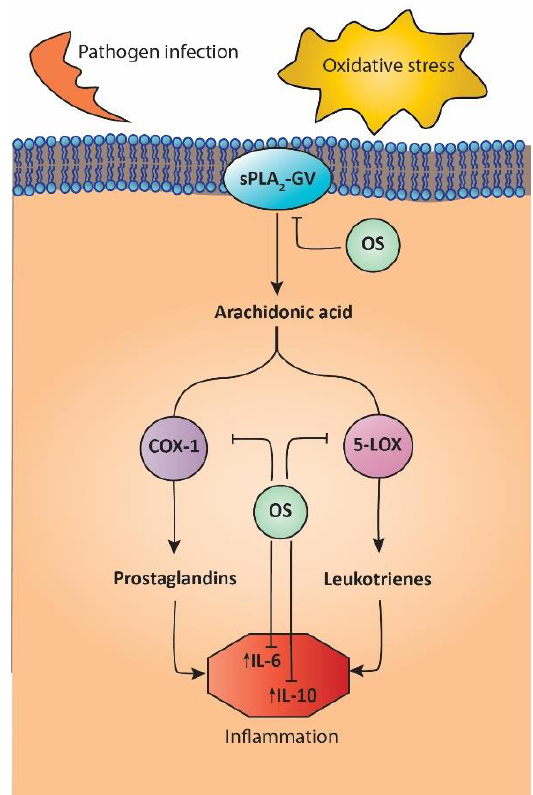
Figure 4. Origanum syriacum modulates the inflammatory response. Origanum syriacum blocks the hydrolysis of arachidonic acid from phospholipid membranes by the phospholipase A2 sPLA2-GV, which is normally released by inflammatory stimuli resulting from pathogen infection and oxidative stress. Origanum syriacum also blocks the conversion of arachidonic acid to pro-inflammatory mediators such as prostaglandins and leukotrienes by inhibiting COX-1 and 5-LOX enzymes, respectively, in addition to inhibiting the production of the pro-inflammatory cytokines IL-6 and IL-10, therefore playing a major role in the pathophysiology of inflammation. OS: Origanum syriacum ; sPLA2-GV: Secretory phospholipase A2-Group V; COX-1: cyclooxygenase-1; 5-LOX: 5-lipooxygenase; IL-6: interleukin-6; IL-10: